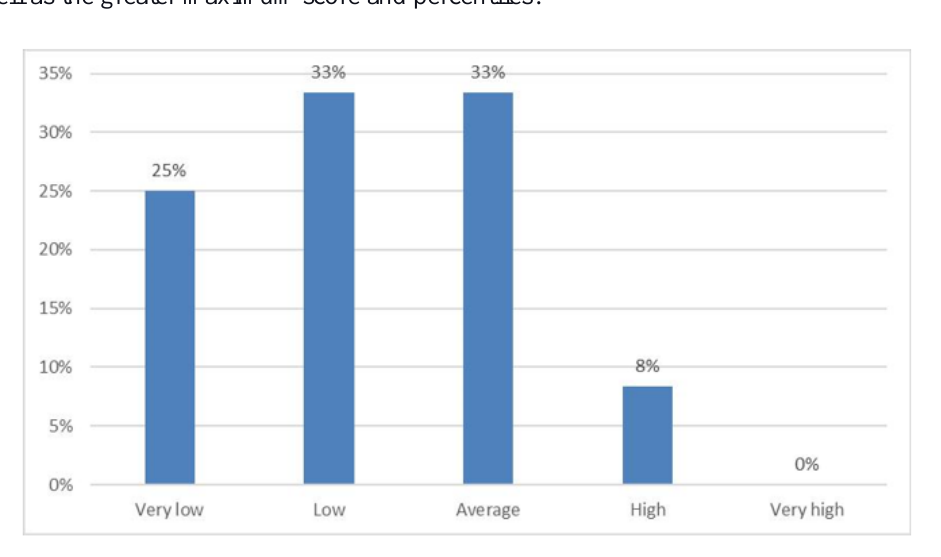
Figure 17. Unexpected Reductions in Returns and Profits (%) Table 2. A Lack of Effective Plans for Addressing Supply Chain Disruptions (Descriptive